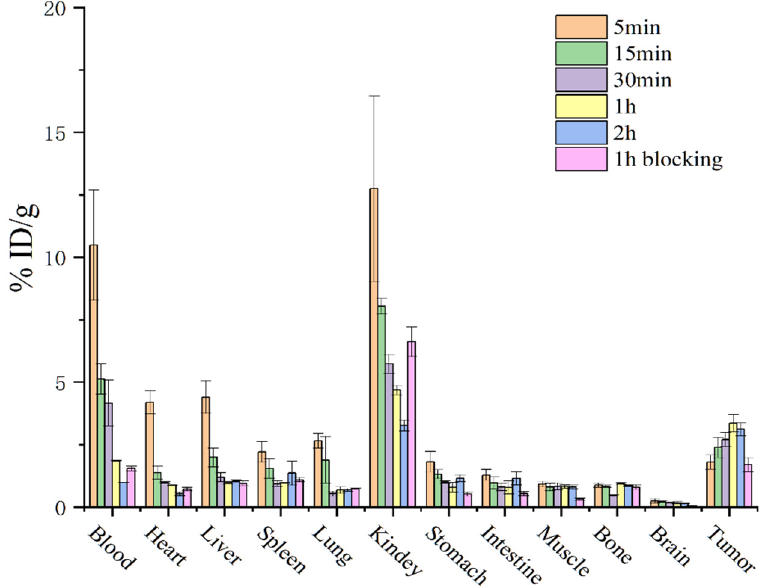
Figure 5. Biodistribution of [ 68 Ga]Ga-DOTA-M2pep in B16F10 tumor-bearing mice ( n = 3) at different time points. In the blocking group, the biodistribution was examined in B16F10 tumor-bearing mice ( n = 3) at 60 min post-injection of [ 68 Ga]Ga-DOTA-M2pep. Data are presented as %ID/g and are expressed as mean ± SD.